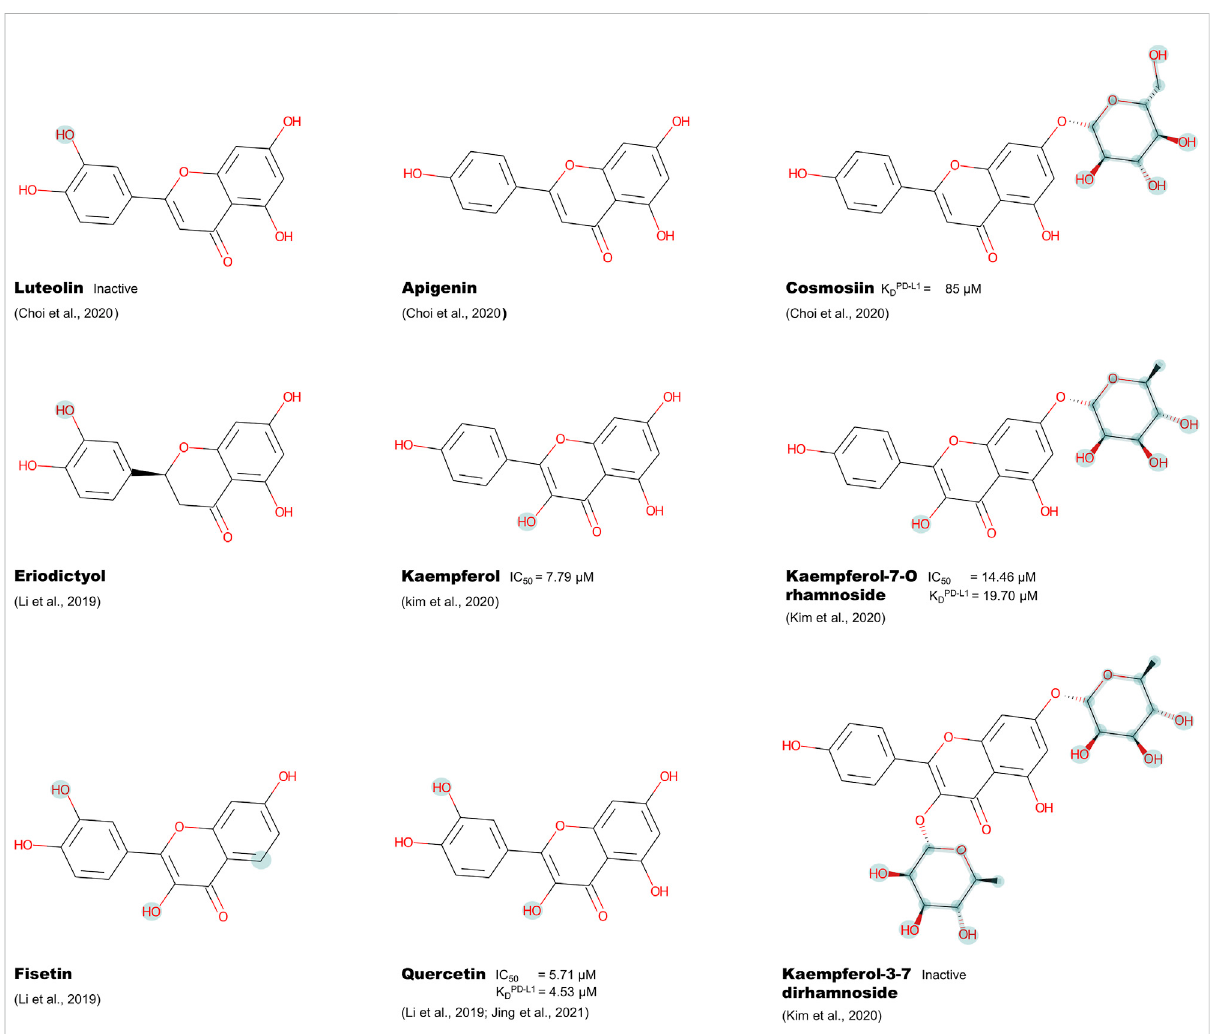
FIGURE 3 Chemical structure of selected fl avonoids with the determined KD or IC50 against PD-1 or PD-L1, highlighting the different functional groups compared to apigenin.